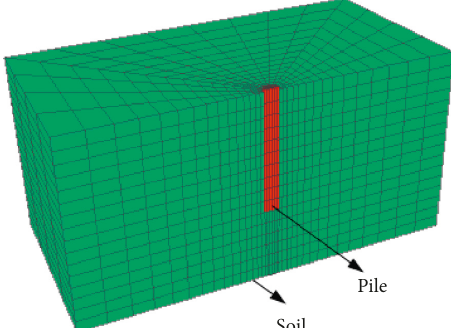
Figure 11: Pile bearing calculation model.